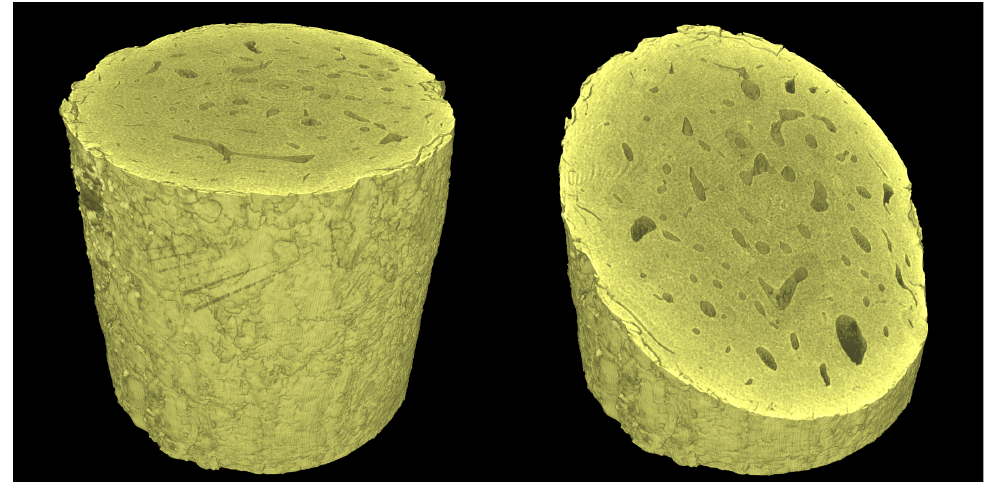
Figure 4. Visualization of the investigated sample based on the reconstructed 3D image in the intact